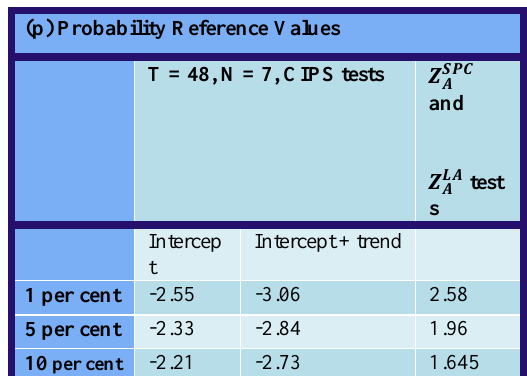
Table 1: Probability Reference Values (p) for Unit Root